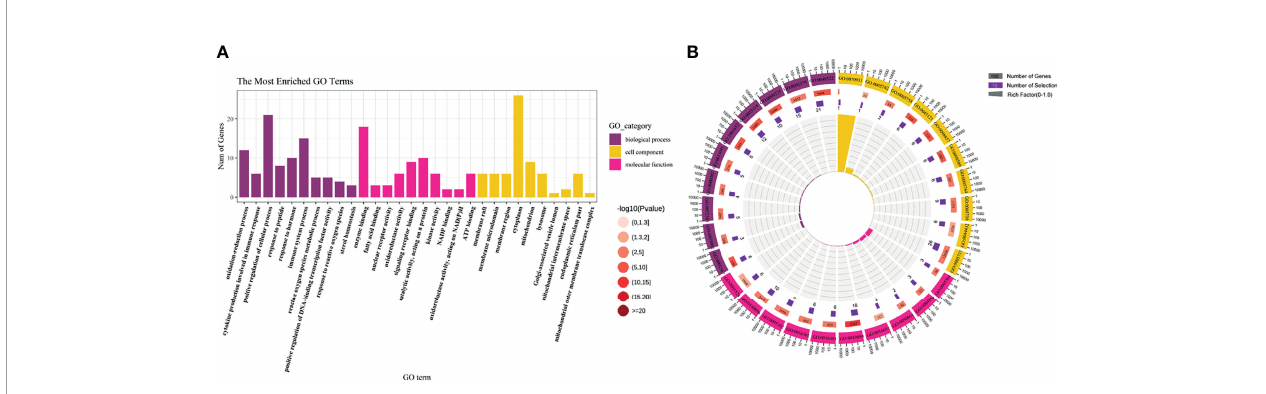
FIGURE 3 | GO enrichment analysis. (A) The top 10 signi fi cantly enriched terms of each part. BP, biological process, CC, cell component, MF, molecular function. (B) The fi rst lap indicates top 10 GO term, and the number of the genes corresponds to the outer lap. The second lap indicates the number of the genes in the genome background and -lg (p-value). The third lap indicates the DEGS. The fourth lap indicates the enrichment factor of each GO term.